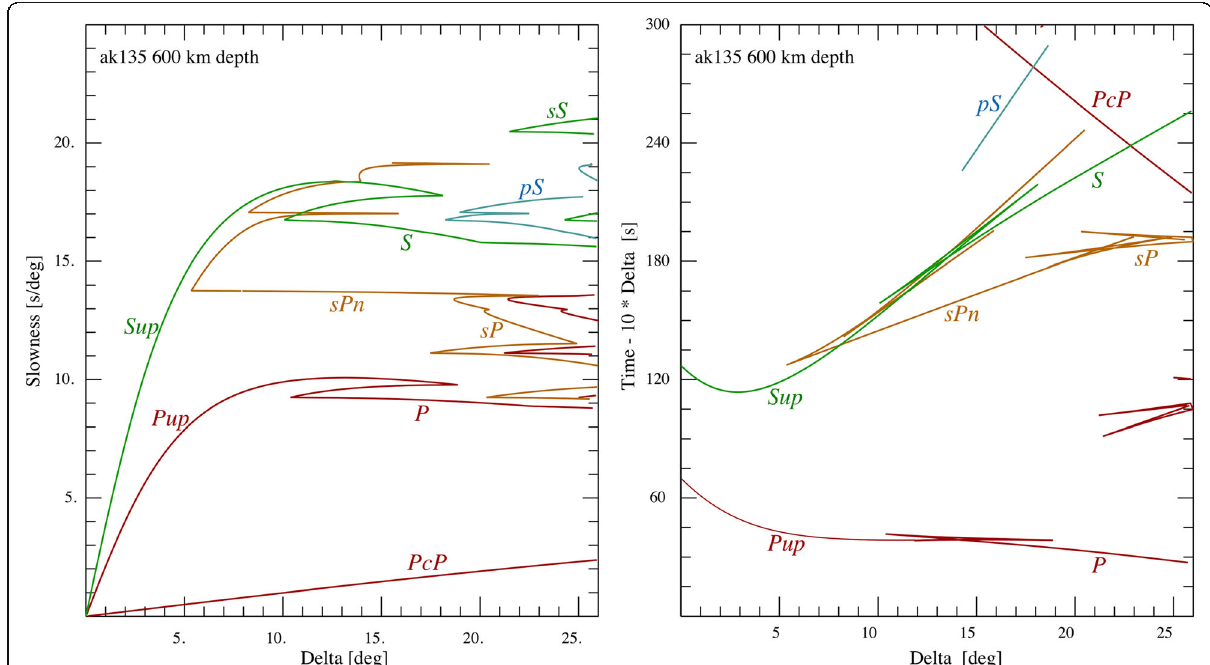
Fig. 2 Summary of propagation characteristics of major P and S phases and converted phases at the free surface for a 600-km-deep source using the ak135 velocity model (35 km crust), for both slowness (left) and travel time (right) as a function of distance